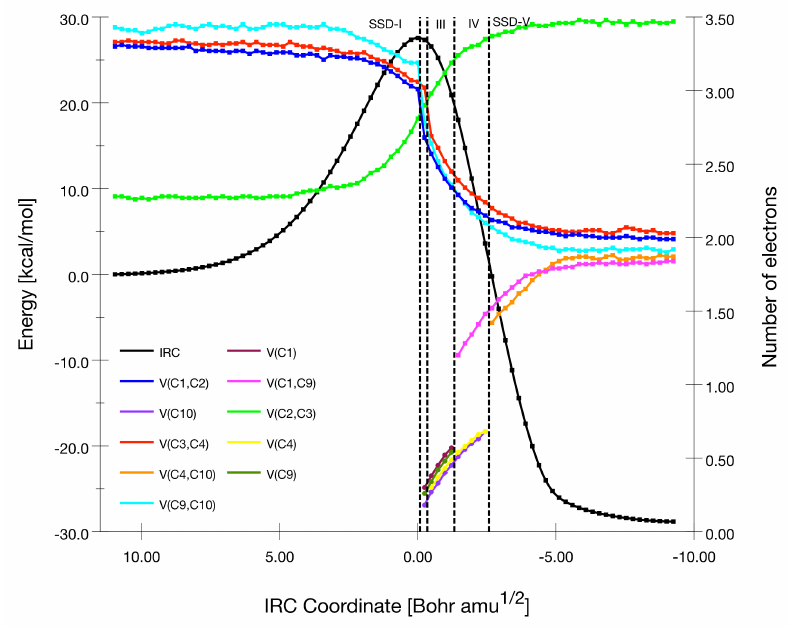
Figure 3. Population evolution (in e) of selected basins along the IRC associated with TS2-a